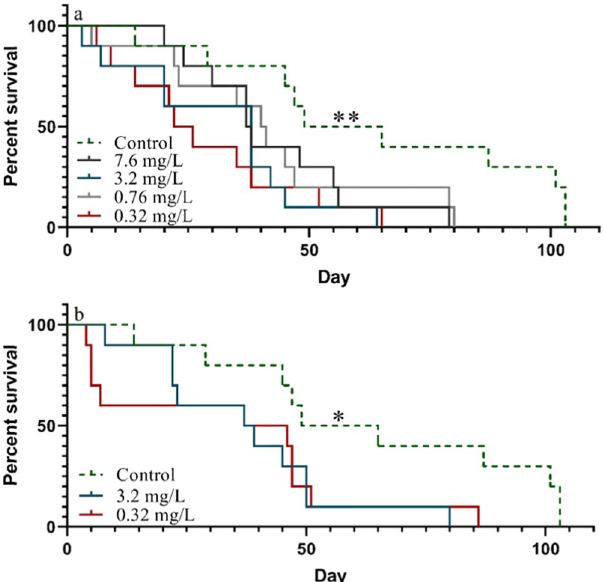
Figure 3. Survival of Daphnia magna exposed to 62 nm PS-COOH ( a ) and 26 nm PS-COOH ( b ) particles throughout their life-time. Asterisks indicate significant differences throughout the study period compared to the control group, * p < 0.05, ** p < 0.01. Asterisks added on the control group indicate that all treatments were significantly different from the control